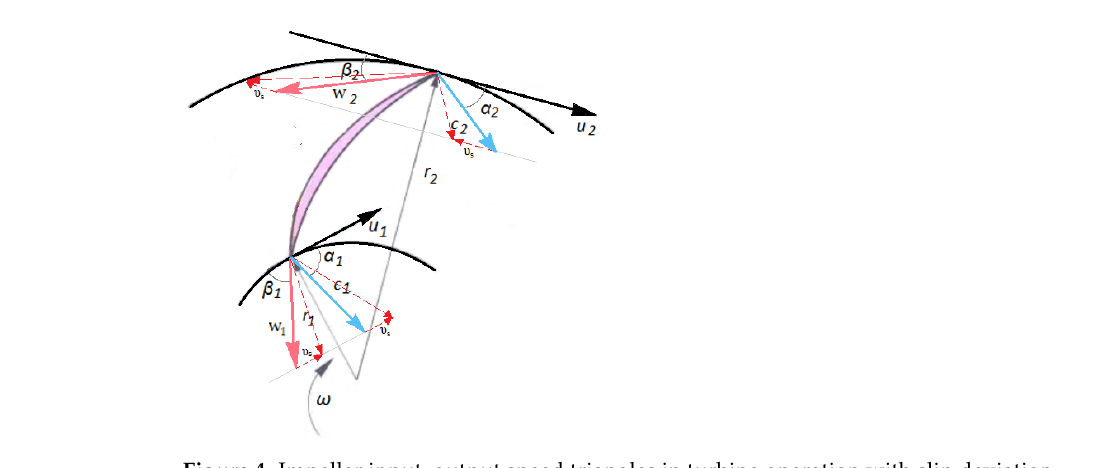
Figure 4. Impeller input–output speed triangles in turbine operation with slip deviation.